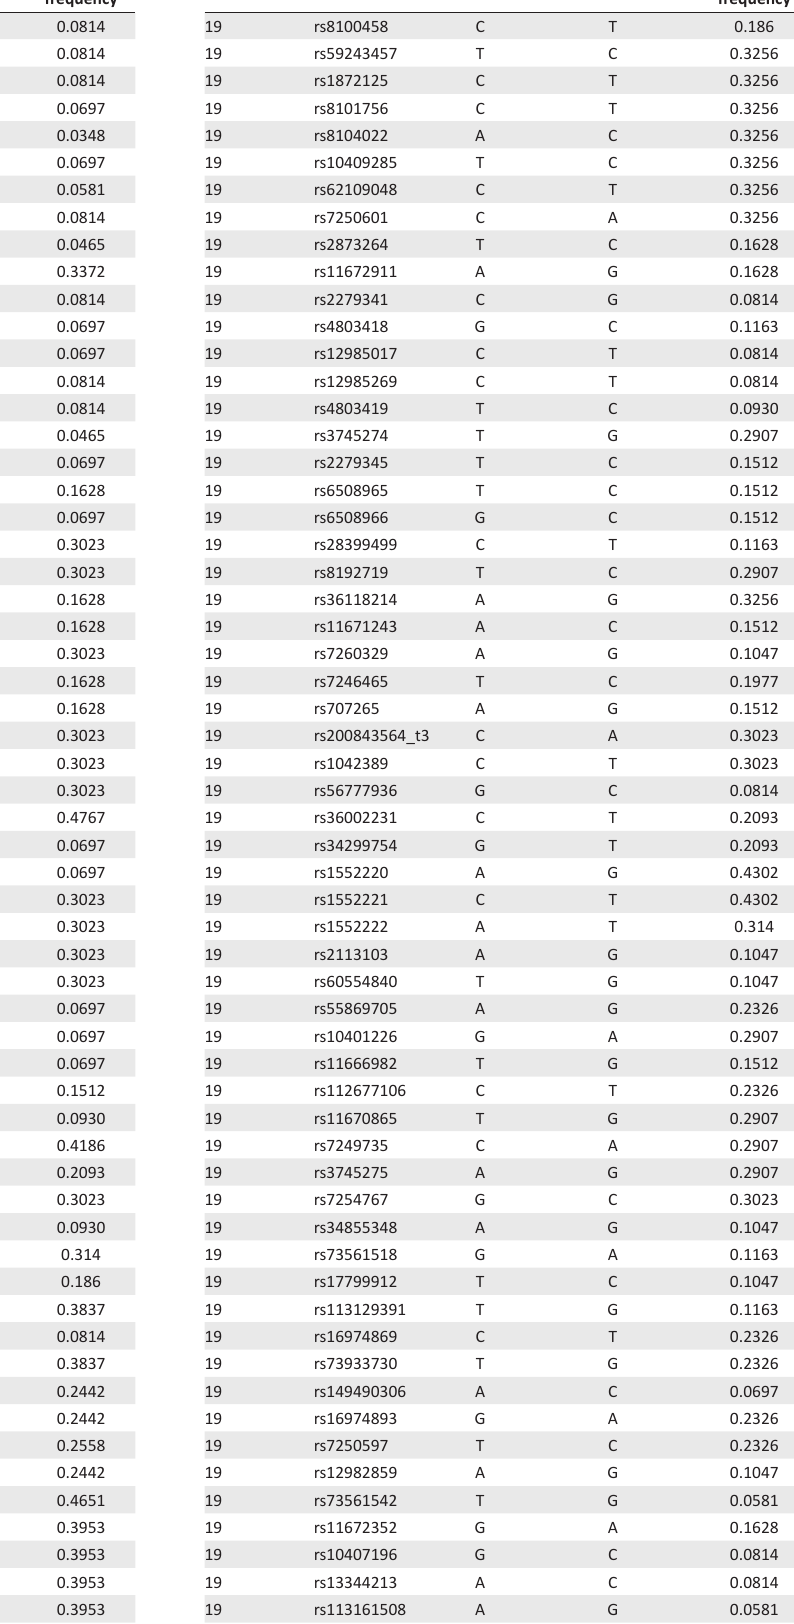
Table 1-A1 (Continues...): Minor allele frequencies for 1846 polymorphisms in 43 black South Africans. Chromosome Polymorphism Minor allele